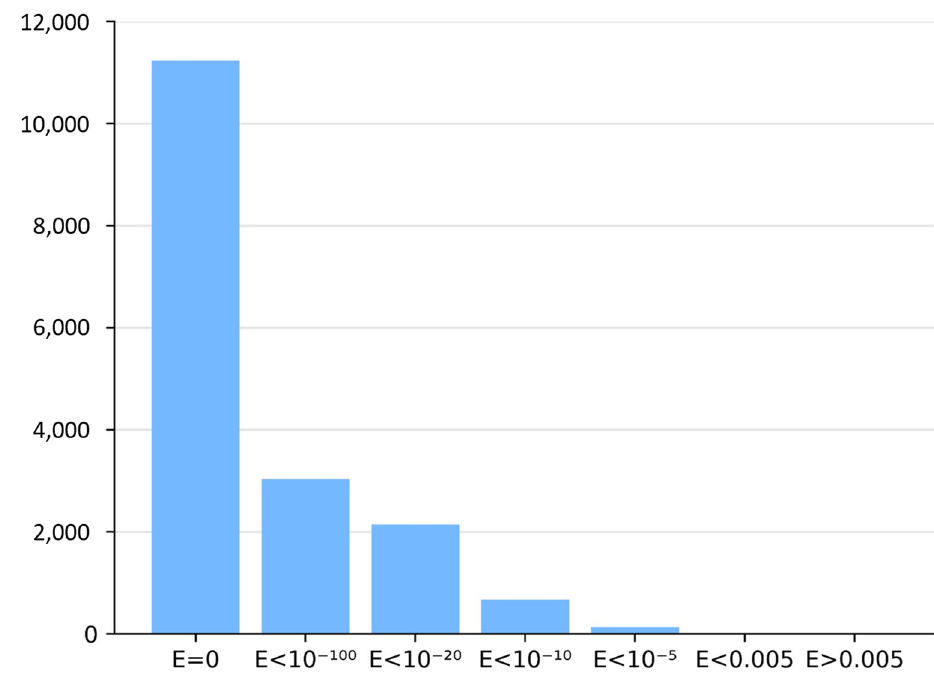
Figure 2. Histogram of BLASTP E-values in neighbor identification step.